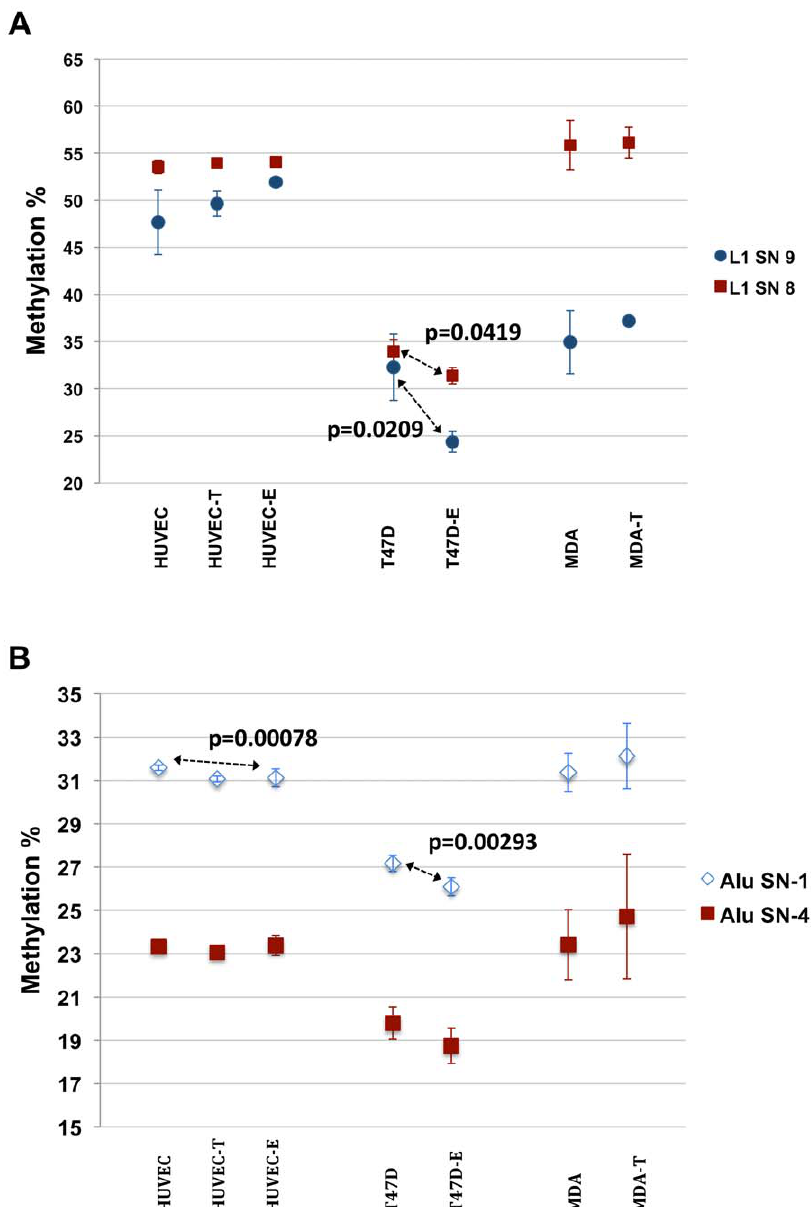
Figure 3. Effect of Hormone treatment on DNA methylation levels at A) LINE-1 and B) Alu. The 48 hours hormone response in HUVEC, T47D-KBluc and MDA cells. T and E stands for dihydrotestosterone and estradiol respectively. Each value corresponds to three different cell culture treatments, each measured thrice for methylation (making a total of 9 measurements).